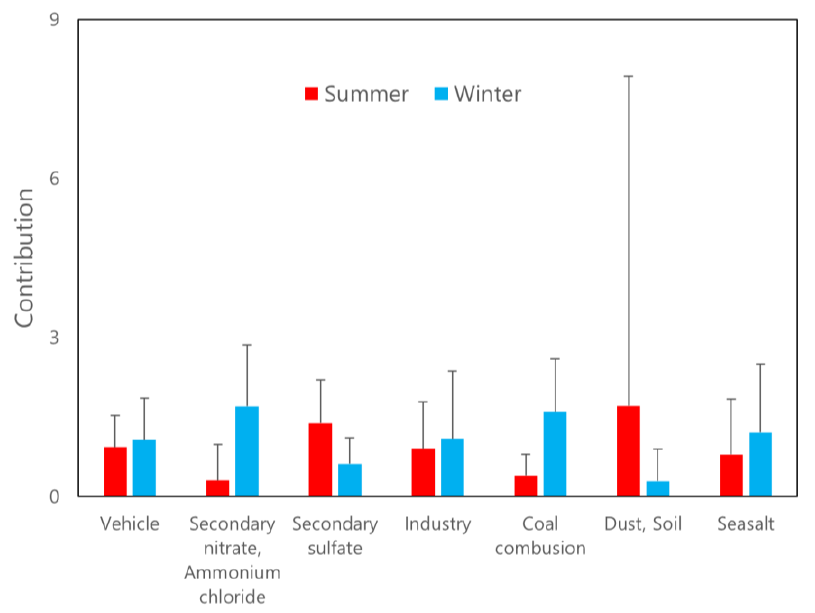
Figure 6. Average seasonal source contribution at the Central Air Environment Research Center of NIER .